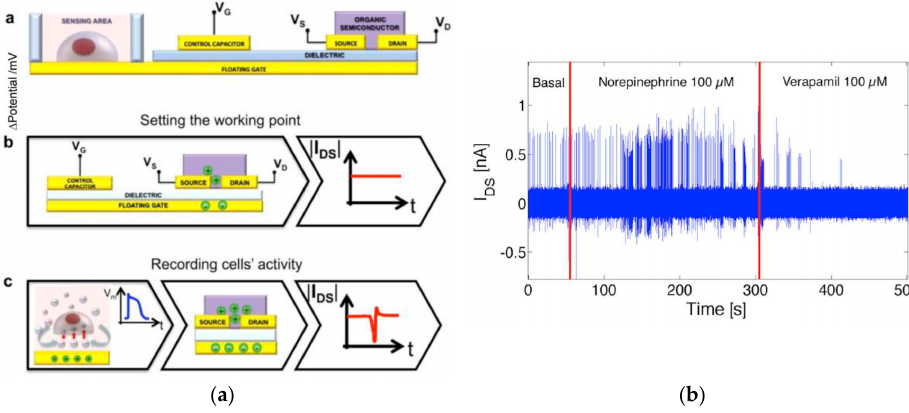
Figure 17. ( a ) Principle of the organic charge-modulated FET (OCMFET) (cross-section and working principles). The charge fluctuation over the sensing area determines the charge re-distribution inside the floating gate, which modulates the charge carriers’ density inside the channel of the transistor; ( b ) rat cardiomyocytes activity maintained at 37 °C for 8 days and measured with an OCMFET. The device is able to evidence that cell activity is accelerated by the addition of norepinephrine or attenuated with verapamil. Adapted from Spanu et al. [12], under the Creative Commons Attribution License (CC BY